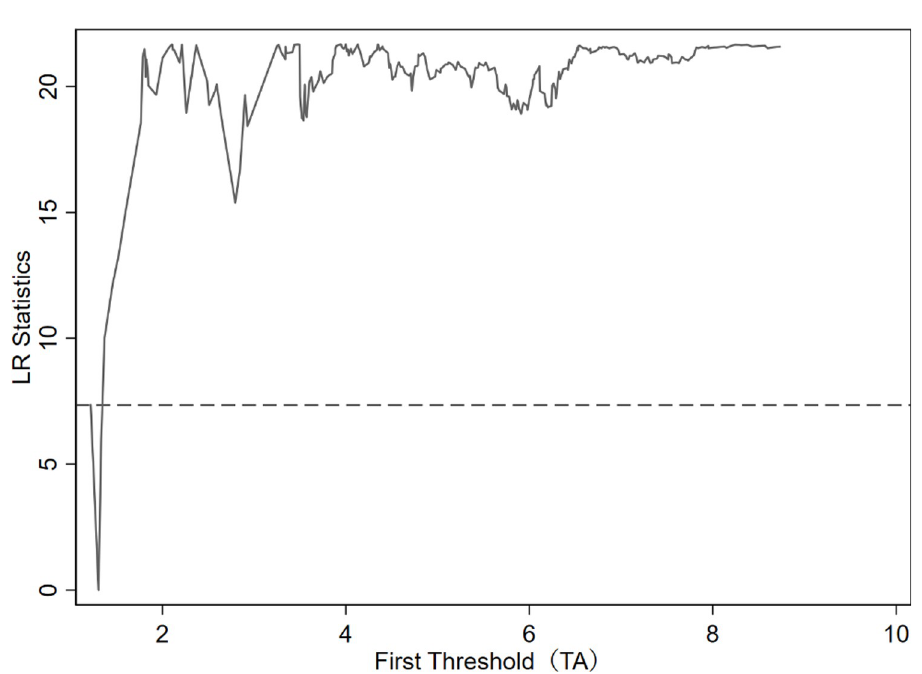
Fig 1. The first threshold estimate and confidence interval.